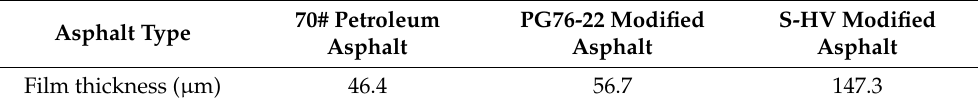
Table 8. Asphalt film thickness on the granite surface.